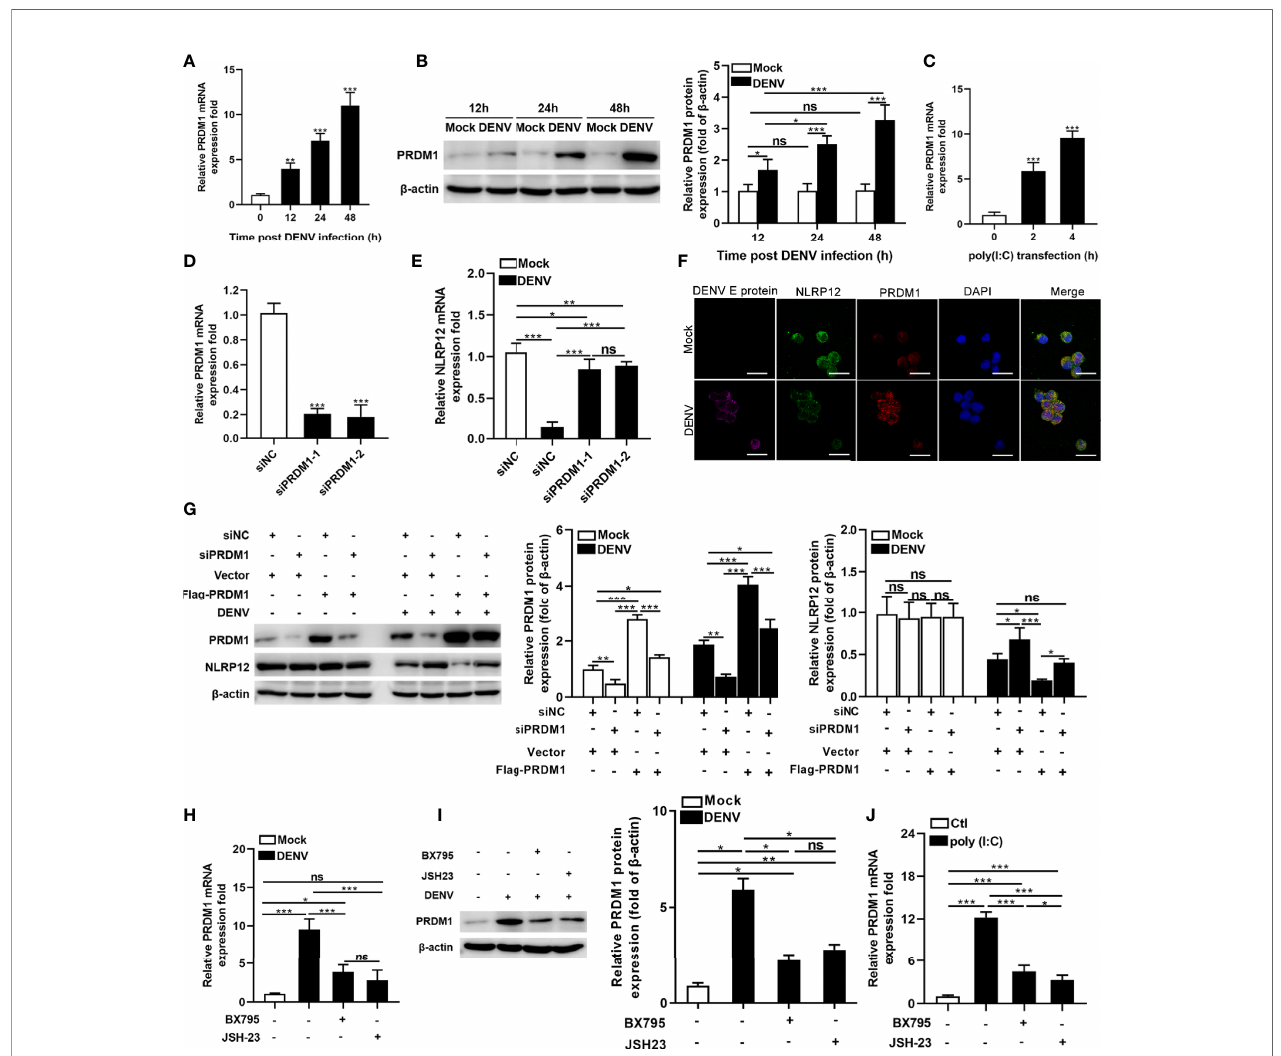
FIGURE 2 | DENV suppressed NLRP12 expression by up-regulating PRDM-1 expression in a manner dependent on the TBK1/IRF3 and NF- k B signaling pathways. (A, B) hMDMs were infected with DENV (MOI=4) for indicated time periods and PRDM1 expression was determined by qPCR and western blot. The gray value of PRDM1 protein bands was analyzed by Image J gel image analysis software, and the relative grayscale value was normalized to that of b -actin. (C) hMDMs were treated with Poly ( I:C ) and harvested for PRDM1 expression analysis. (D) The siRNA knockdown of PRDM1 was performed in hMDMs and the mRNA level of PRDM1 was measured. (E) PRDM1-silenced hMDMs were infected with DENV for 48h (MOI=4) and NLRP12 expression was determined via qPCR. (F) dTHP1 cells were infected with DENV with an MOI of 4 for 72h. Immuno fl uorescence staining was performed for DENV E protein, NLRP12, PRDM1 and DAPI (Bar: 10 m m). (G) dTHP1 cells were transiently transfected with the siRNAs against the PRDM1, and then PRDM1-Flag-expressing vectors were transfected into the cells. After DENV infection at a MOI of 4 for 72h, the expression levels of NLRP12 and PRDM1 were detected by western blot analysis. The gray value of PRDM1 protein and NLRP12 bands was analyzed by Image J gel image analysis software and the relative grayscale value was normalized to that of b -actin. (H, I) hMDMs cells were pre-treated with the inhibitors for TBK1 (BX795) or NF- k B (JSH-23) and subjected to DENV infection at a MOI of 4 for 48h, then the PRDM1 transcript and protein levels were determined. The gray value of PRDM1 protein bands was analyzed by Image J gel image analysis software and the relative grayscale value was normalized to that of b -actin. (J) hMDMs cells were pre-treated with the inhibitors for TBK1 (BX795) or NF- k B (JSH-23) and subjected to poly(I:C) treatment, then the PRDM1 transcript level was determined. Each experiment was repeated a minimum of three times and the statistical signi fi cance was determined with analysis of one-way analysis of variance (ANOVA). ns, nonsigni fi cant, *P < 0.05, **P < 0.01, ***P <